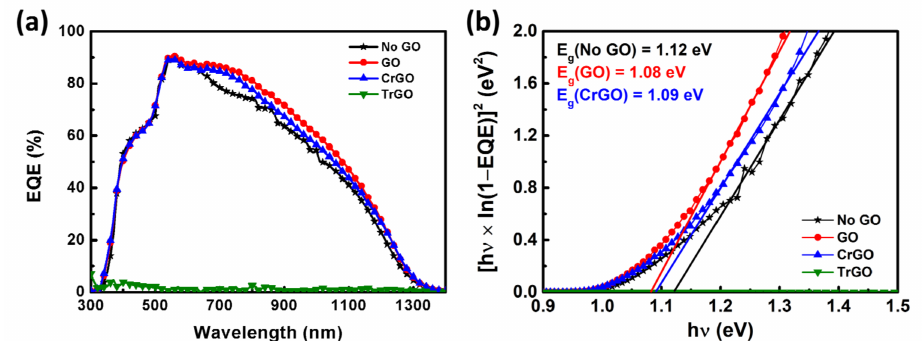
Figure 6. ( a ) External quantum efficiency (EQE) curves of the CZTSSe solar cells and ( b ) the bandgap energies ( E g ) of the CZTSSe absorber layers obtained from the EQE